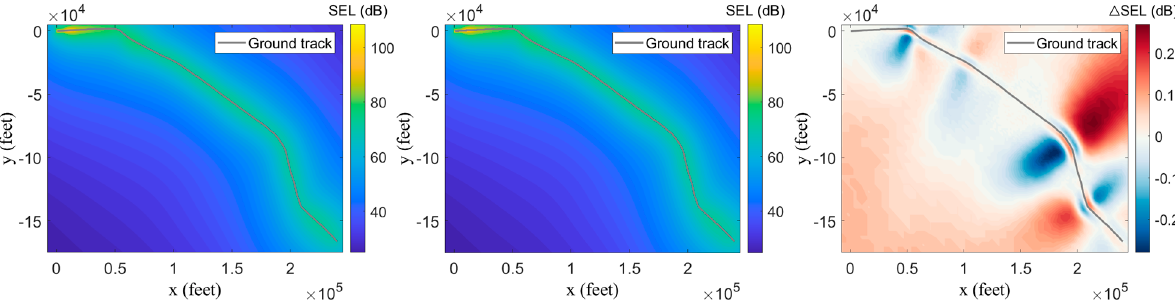
Figure 23. A330 aircraft departing from HKIA. Noise impact (SEL) generated by flight AD2 with (left) and without (center) the incorporation of the installation effect (bank angle), along with the difference between both results (obtained by subtracting the former from the latter, right).